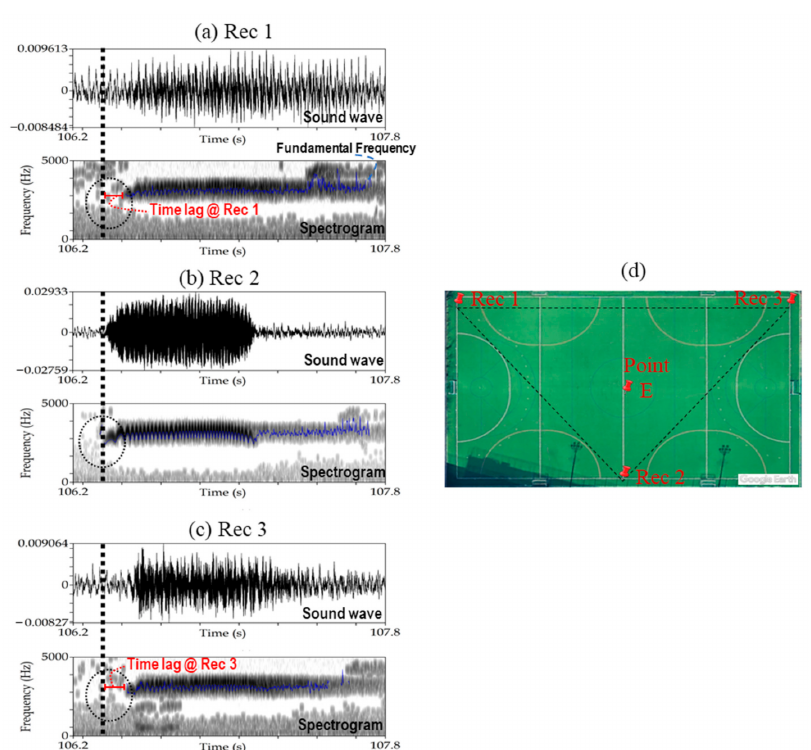
Figure 5. Sound editor windows of Praat software show the sound waves and spectrogram of a recorded sound at ( a ) Rec 1, ( b ) Rec 2, and ( c ) Rec 3 in UTokyo experiment. The recorded sound at the three recorders was emitted from a whistle located at point E whose position is shown in ( d